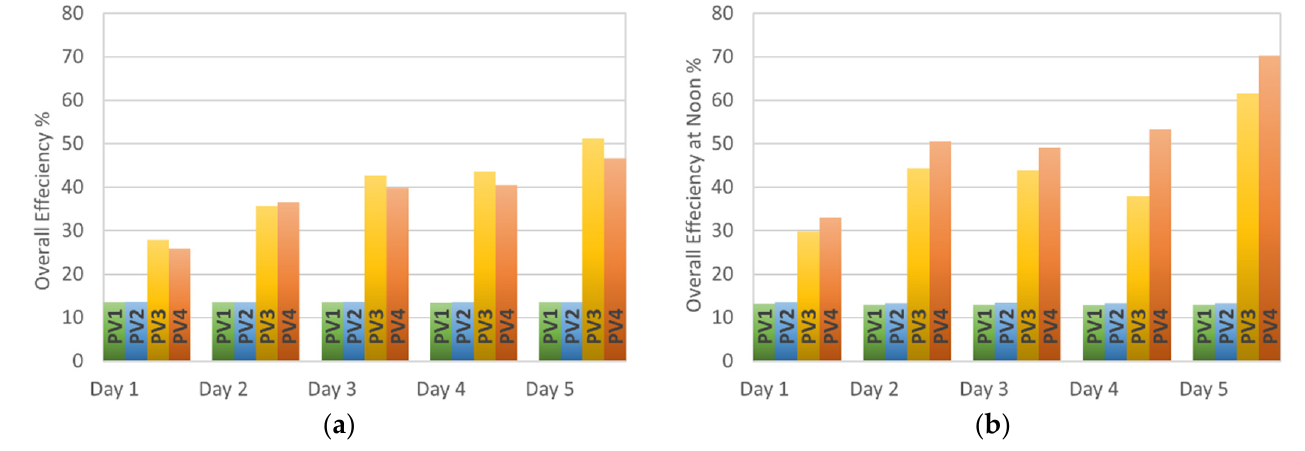
Figure 9. The average overall efficiency of the four PV panels: ( a ) over the day from 9:30 to 16:30, and ( b ) around noon from 11:00 to 13:00.